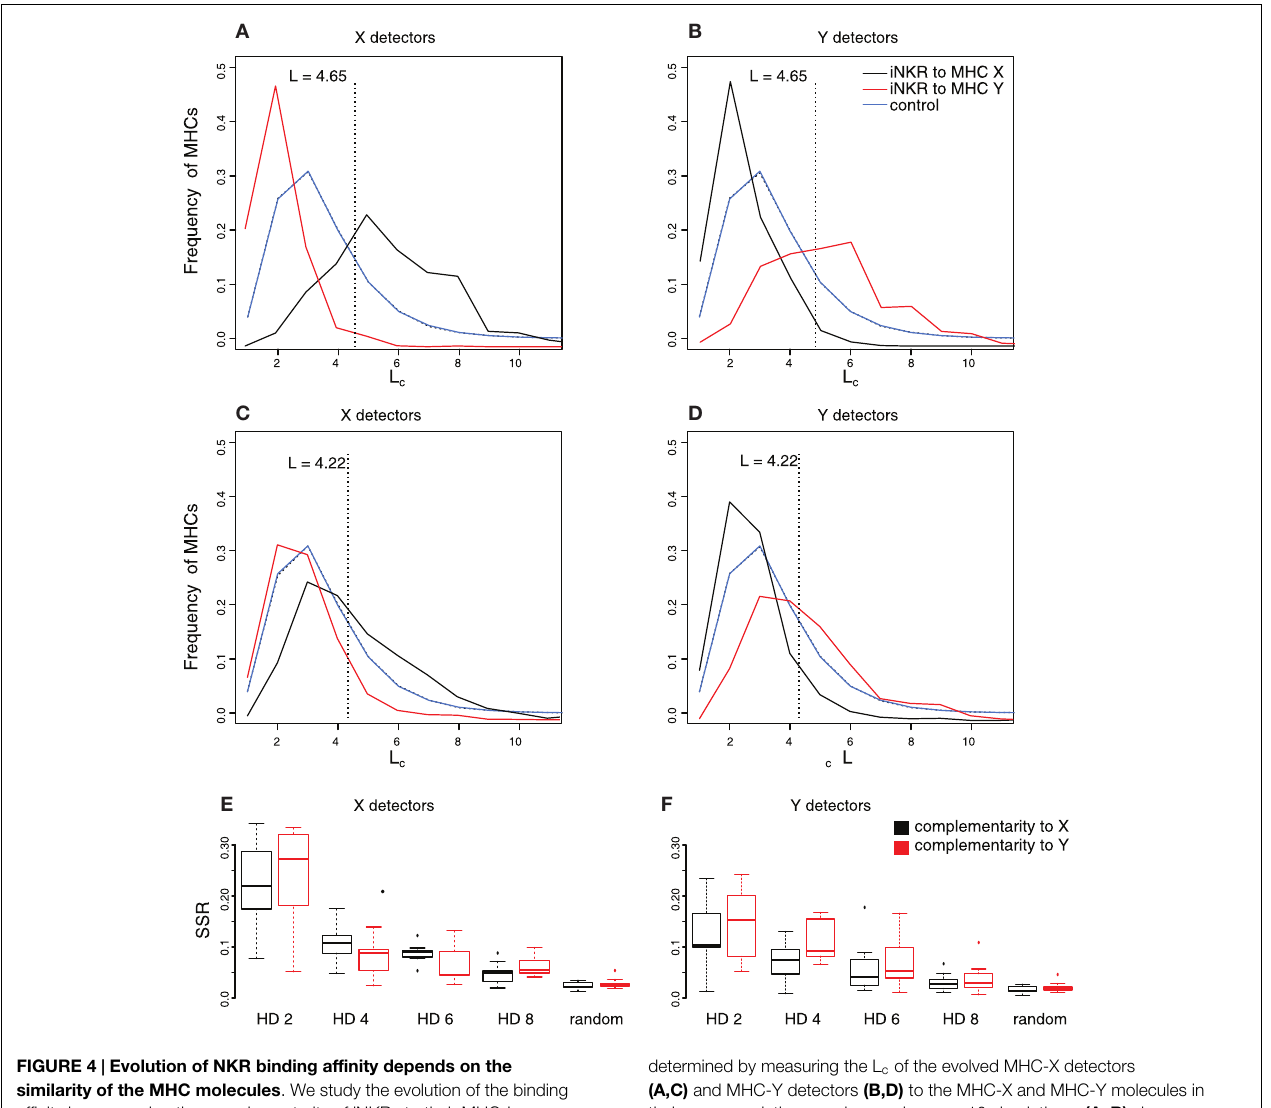
FIGURE 4 | Evolution of NKR binding affinity depends on the similarity of the MHC molecules . We study the evolution of the binding affinity by comparing the complementarity of iNKRs to their MHC-I molecules. (A–D) depict the fraction of MHC molecules that are recognized with a particular complementary adjacent length L c . The blue curve describes the expected frequency distribution determined by measuring the L c between 1000 random NKRs and a pool of random MHC molecules, and repeating this experiment 1000 times. The black and red curves represent the frequency distribution of the evolved iNKRs to MHC-X and MHC-Y molecules, respectively, at t end . The frequency distribution was